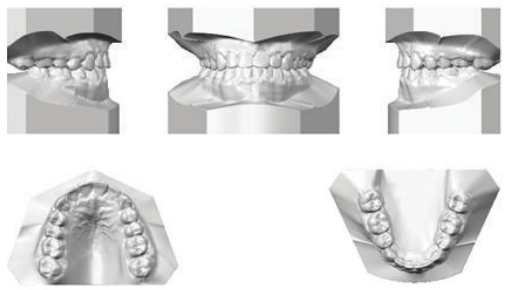
Figure 17: Stage 2: Orthodontic Treatment Final Models.